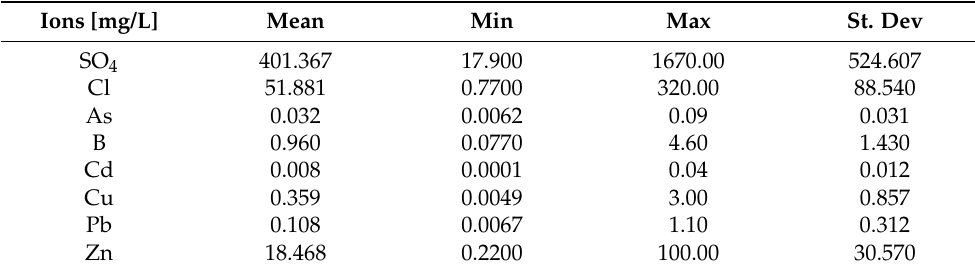
Table 5. Results of physicochemical analyses of the leachates